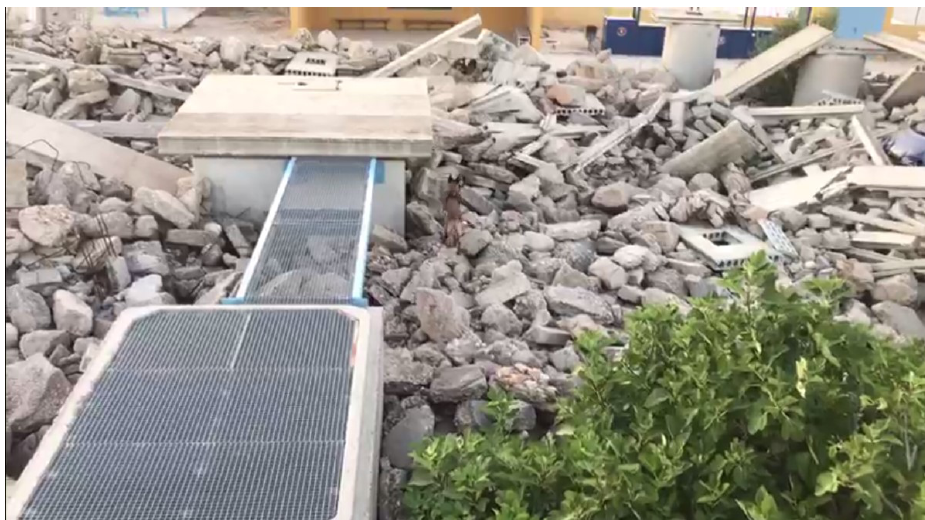
Figure 5. Arena used to conduct search and rescue